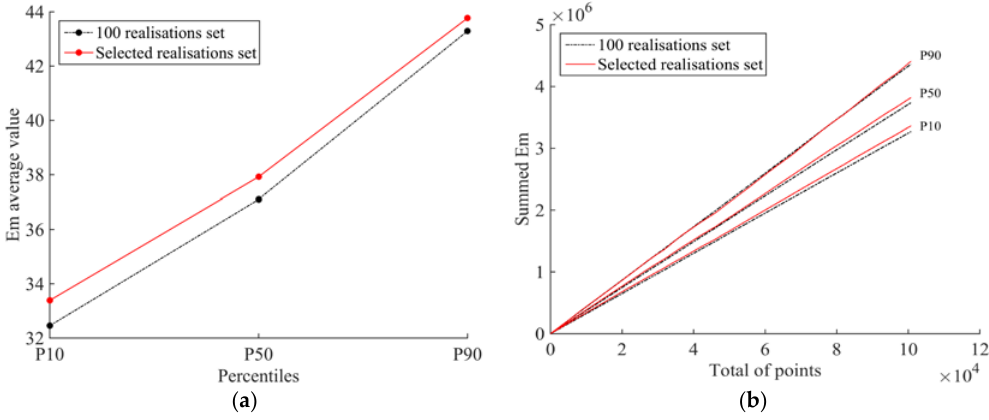
Figure 8. Validation of the four-cluster configuration in comparison with the 100 realisations using: ( a ) the average values of percentiles 10, 50, and 90; ( b ) a point-by-point percentile sum.